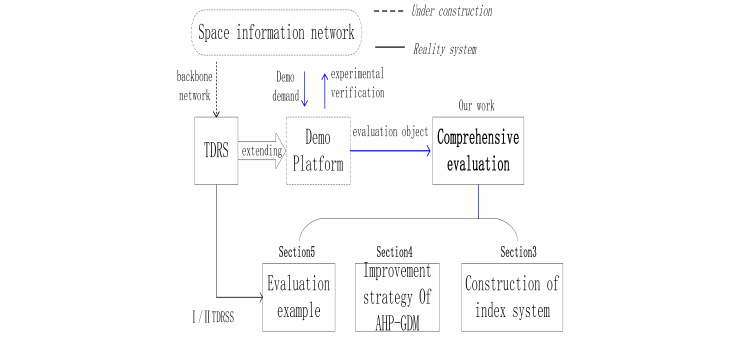
Figure 1. The logical diagram of this